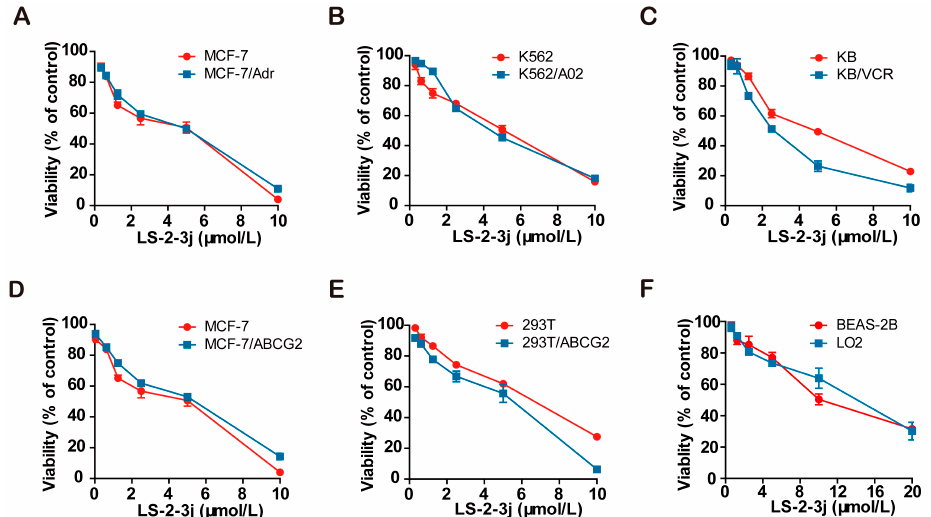
Figure 1. Cytotoxicity of LS-2-3j alone in drug-sensitive and drug-resistant cell lines. An The